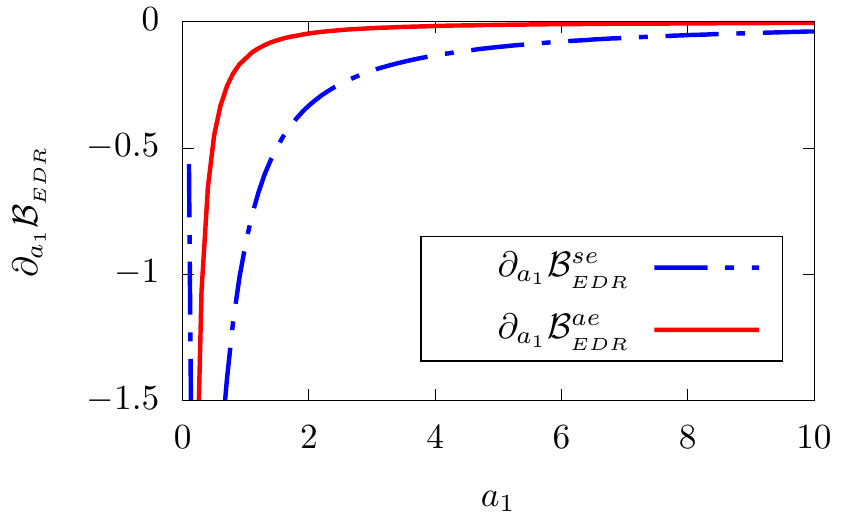
Figure 20 . The quantity ∂ a B is plotted with respect to varying a 1 for accelerated atoms in 1 EDR thermal background considering Rindler modes in (1 + 3) dimensions. For the transition from the symmetric state to the collective excited state the curve is given by the dash-dotted blue line. On the other hand, for the transition from the anti-symmetric state to the collective excited state the curve is given by the solid red line. The positivity of these curves are expected to provide the condition for strong anti-Unruh